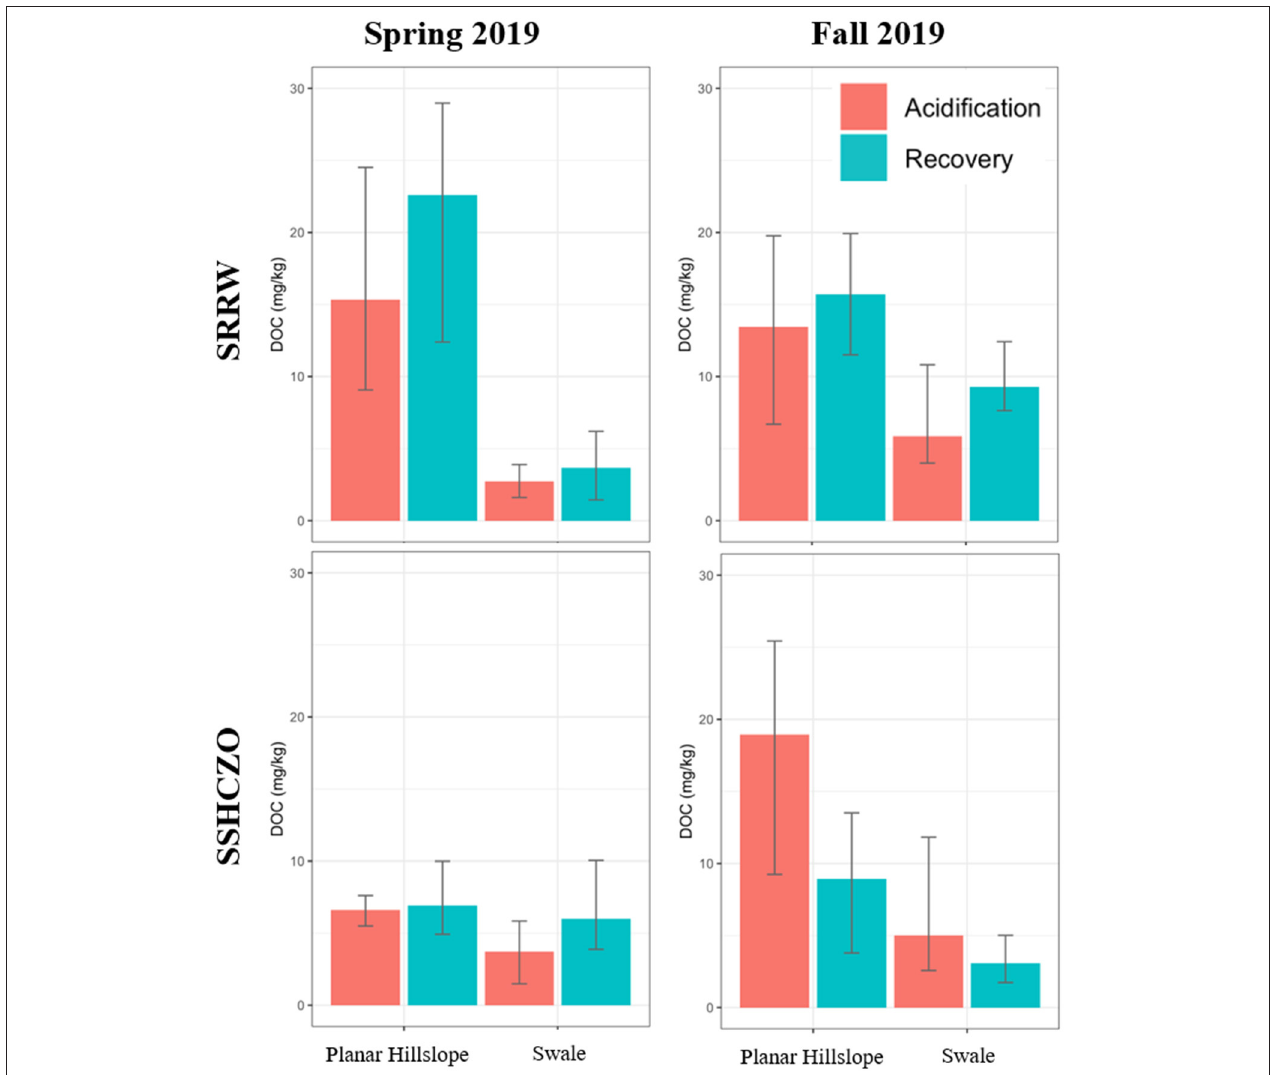
FIGURE 8 | Cumulative DOC effluent released from soil core leaching experiments as a function of treatment, landscape position and